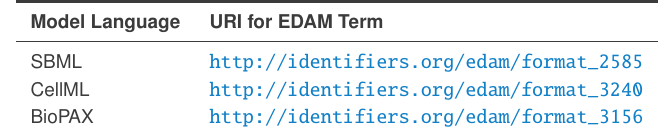
Table 14: Terms from the EDAM ontology to specify the language property of a Model .